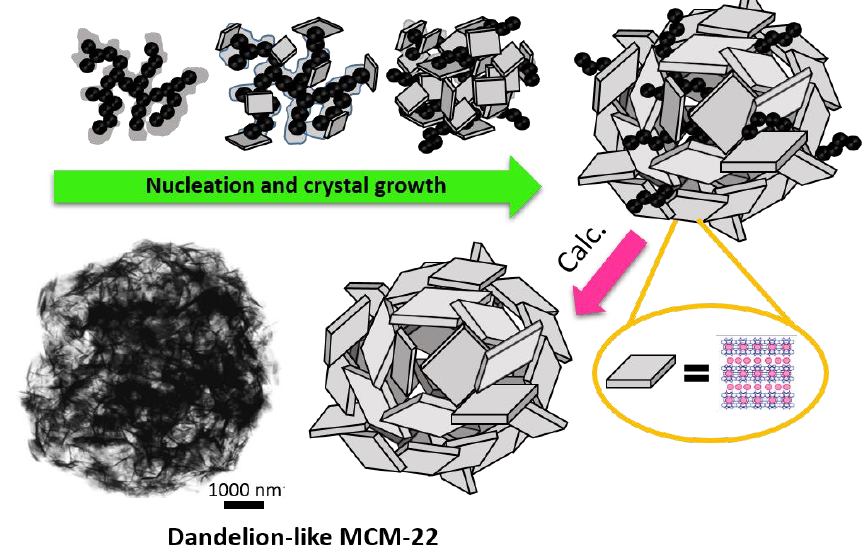
Figure 11. Proposed mechanism of the formation of dandelion-like MCM-22 microspheres. Adapted from Reference [63].